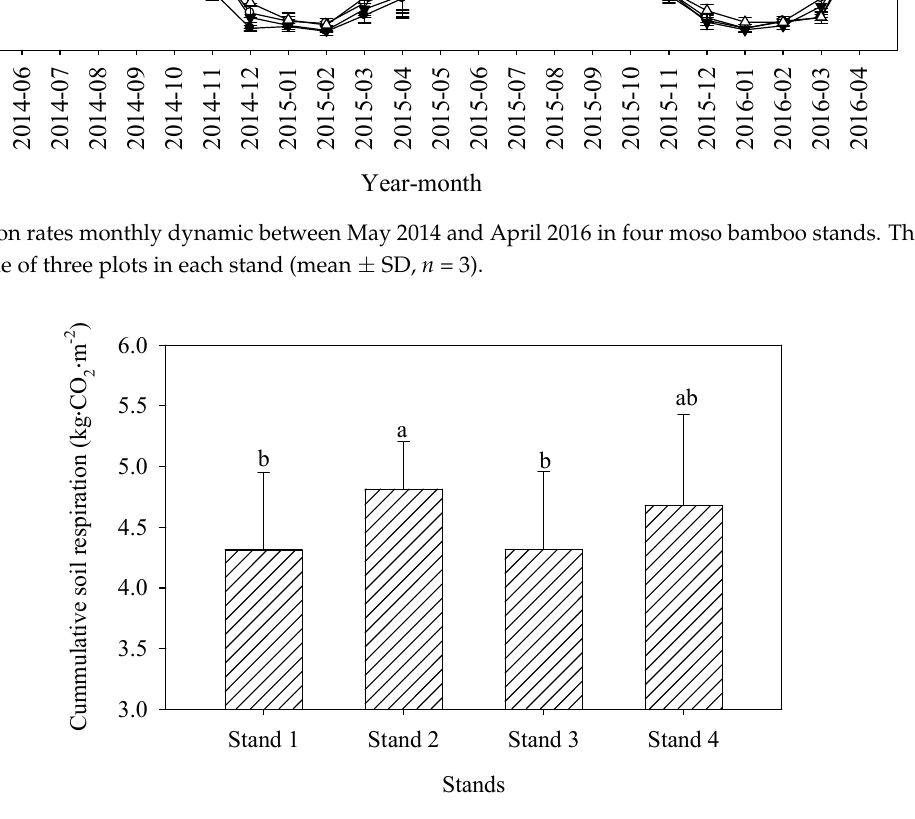
Figure 6. Soil annual cumulative CO 2 emissions in four moso bamboo stands. Different lowercase Figure 6. soil Annual cumulative CO 2 emissions in four moso bamboo stands. Different lowercase